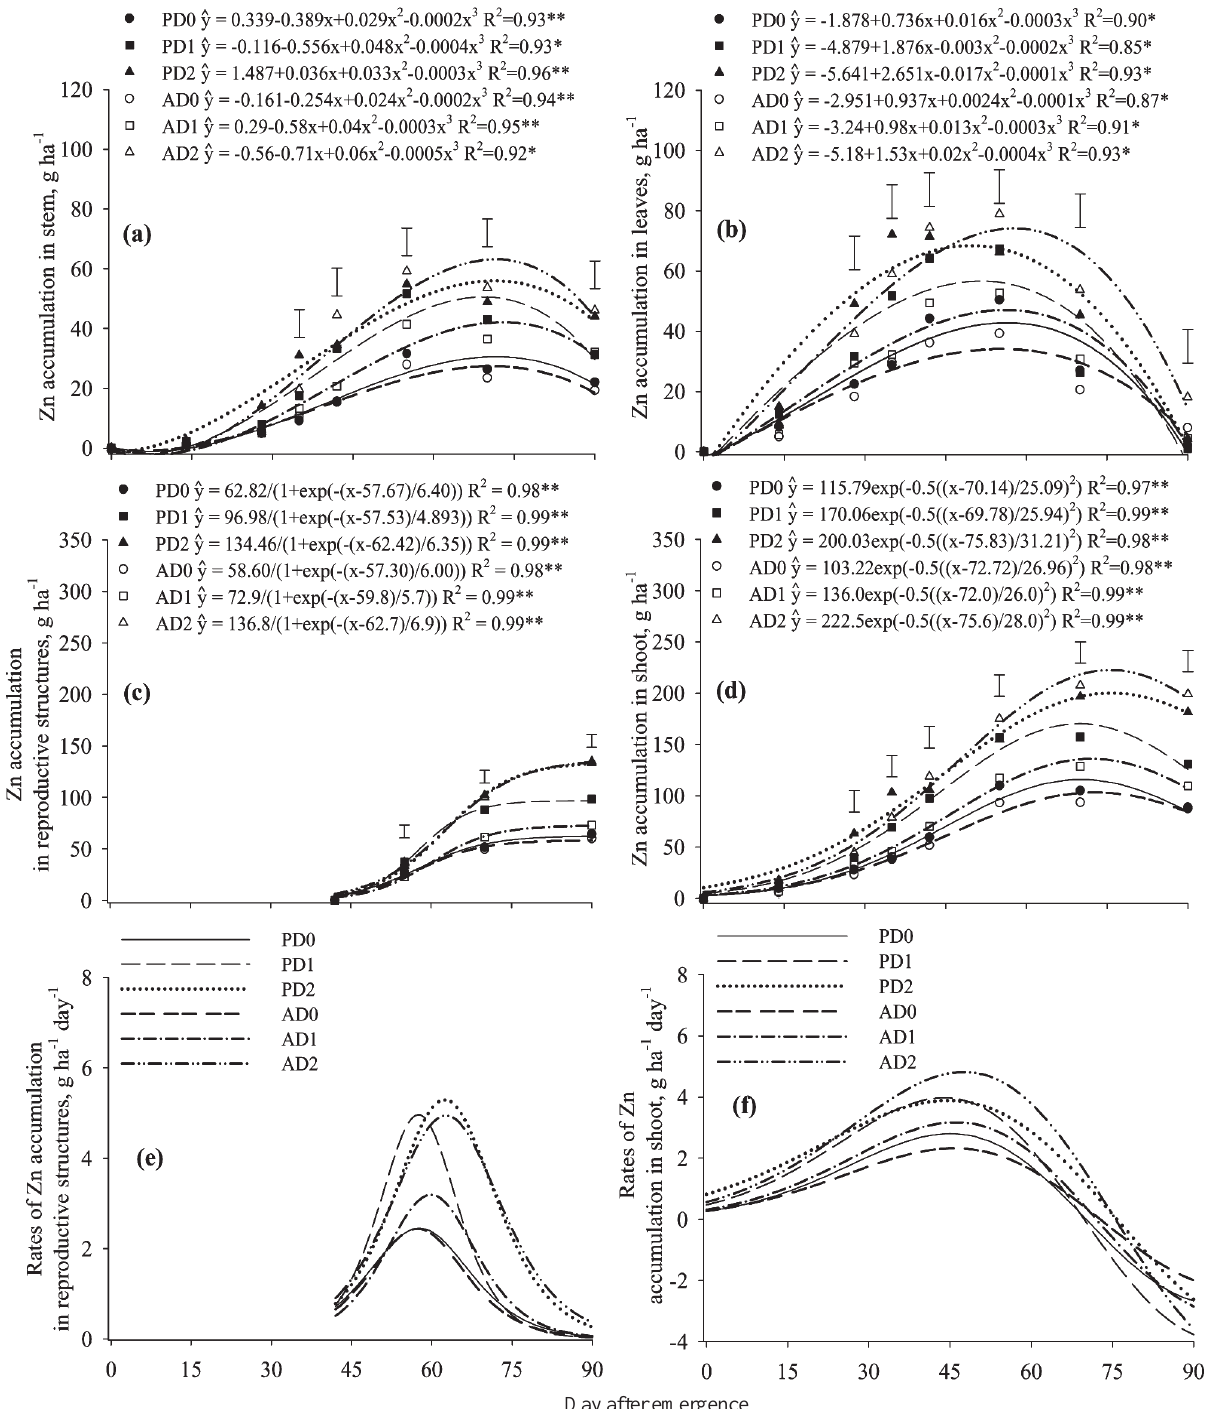
Figure 5. Zinc accumulationin stem (a), leaves (b), reproductive structures (c), and shoot (d) and rates of accumulation of Zn in reproductive structures (e) and shoot (f) of common bean cultivars, under different levels of fertilization. ** and * are: significant at p 0.01 and p 0.05 by the F test. Vertical bars represent the Least Significant Difference (LSD) at p 0.05. PD0 = Pérola without NPK fertilization, PD1 = Pérola with 50 % of recommended NPK fertilization; PD2 = Pérola with 100 % of recommended NPK fertilization; AD0 = IAC Alvorada without NPK fertilization, AD1 = IAC Alvorada with 50 % of recommended NPK fertilization; AD2 = IAC Alvorada with 100 % of recommended NPK